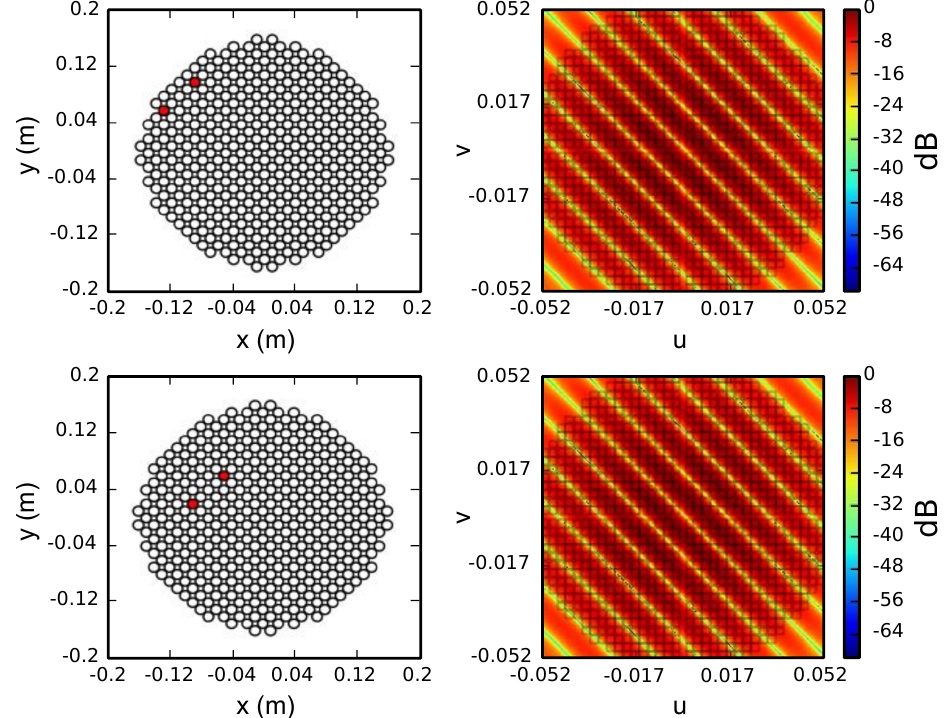
Figure 3. Schematics of QUBIC self-calibration. The pictures in the two rows show that if we open any pair of horns with a given baseline, then we should ideally measure exactly the same interference pattern.